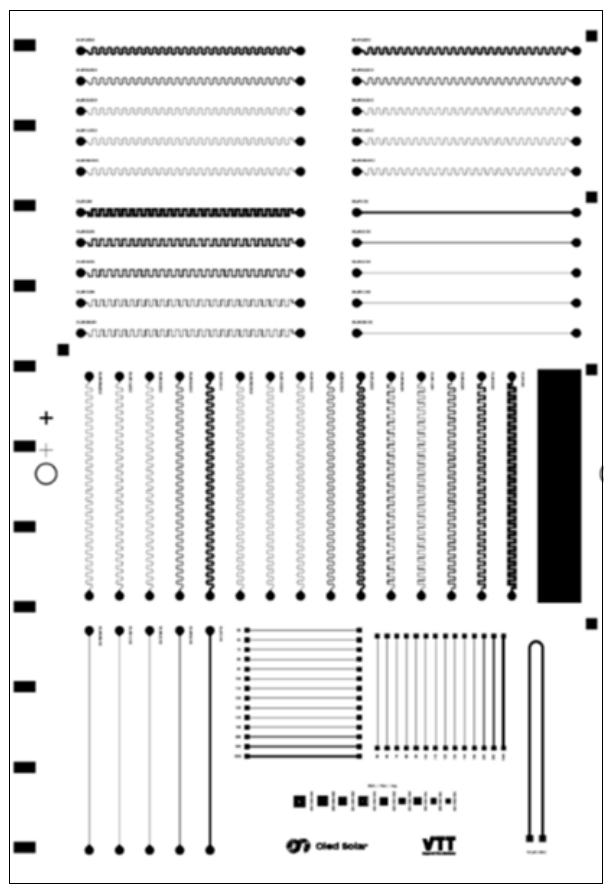
Figure 3. R2R printed silver conductor on PET foil.